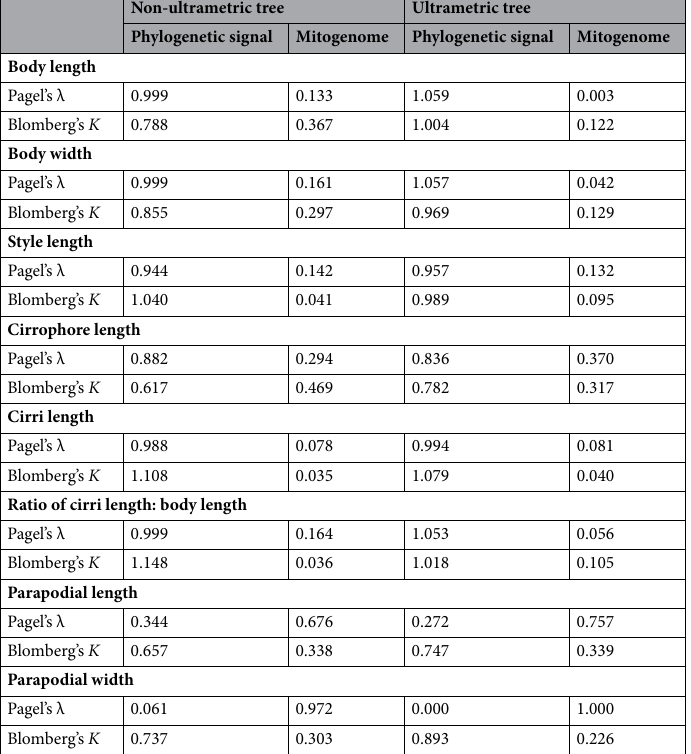
Table 2. Phylogenetic signal and significance values of selected traits. Obtained from Pagel’s λ and Blomberg’s K statistics on non-ultrametric tree generated in RAxML using the concatenated dataset of 13 traits are distributed as expected under a Brownian motion of trait evolution. Values greater than one indicate high phylogenetic signal (high trait similarity between related